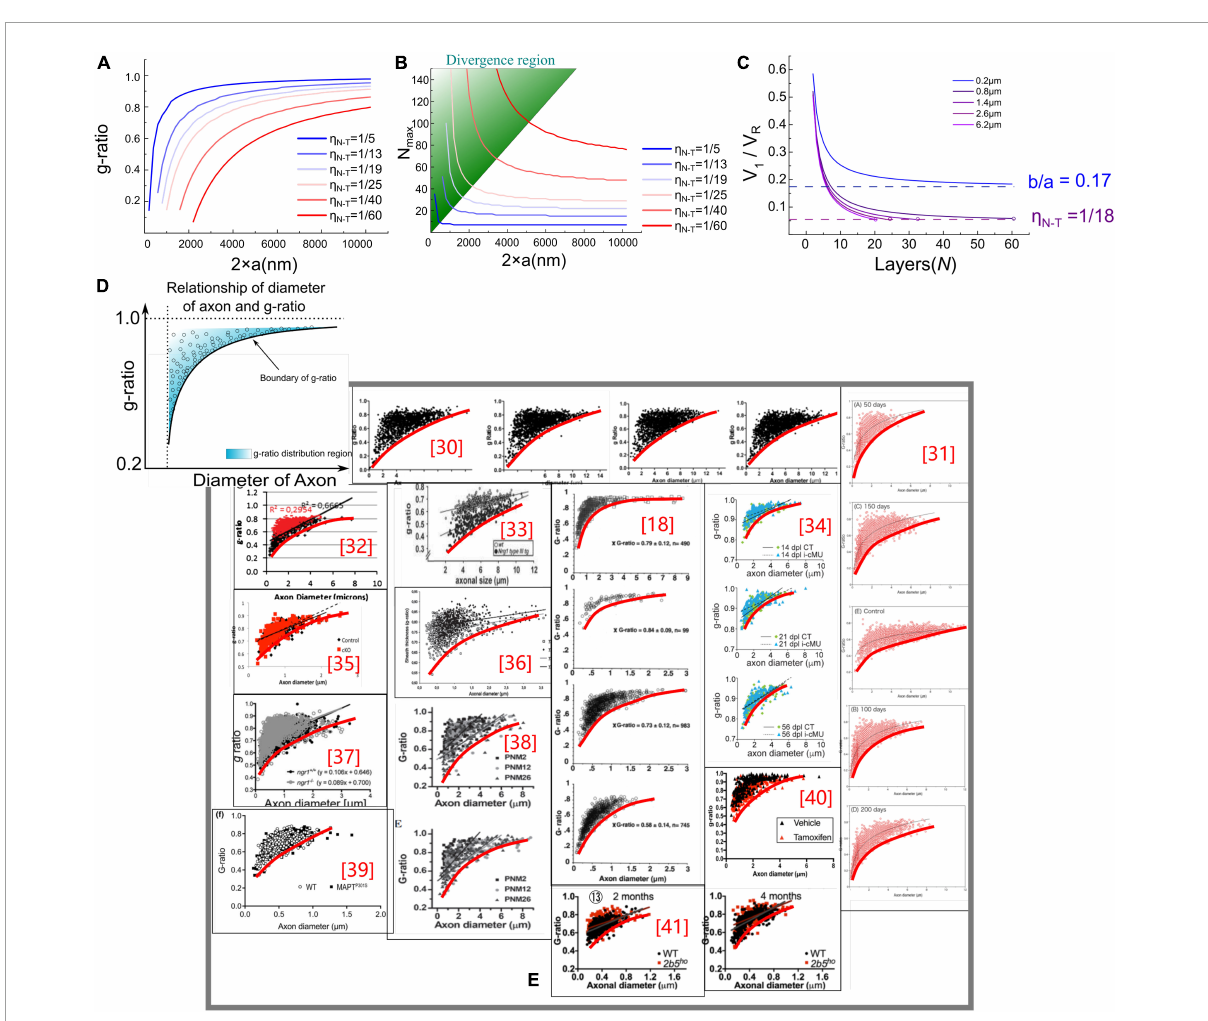
FIGURE3 (A,B) g-ratio values and the maximum number of myelin lamellae, N max values, given different η N − T . (C) The relationship between N max and V 1 /V R . When b/a < η N − T , N max is a finite number, otherwise N max is infinite. (D) Illustration of the claim: the measured statistical data of g-ratio shall locate above the g-ratio curve; (E) the measured statistical data of g-ratio in publications (Michailov et al., 2004; Paus and Toro, 2009; Ikeda and Oka, 2012; FitzGibbon and Nestorovski, 2013; Barbizan et al., 2014; Bercury et al., 2014; Nave and Werner, 2014; Ronchi et al., 2014; Xie et al., 2014; Lee et al., 2017; Dimas et al., 2019; Marro et al., 2019; Ferreira et al.,